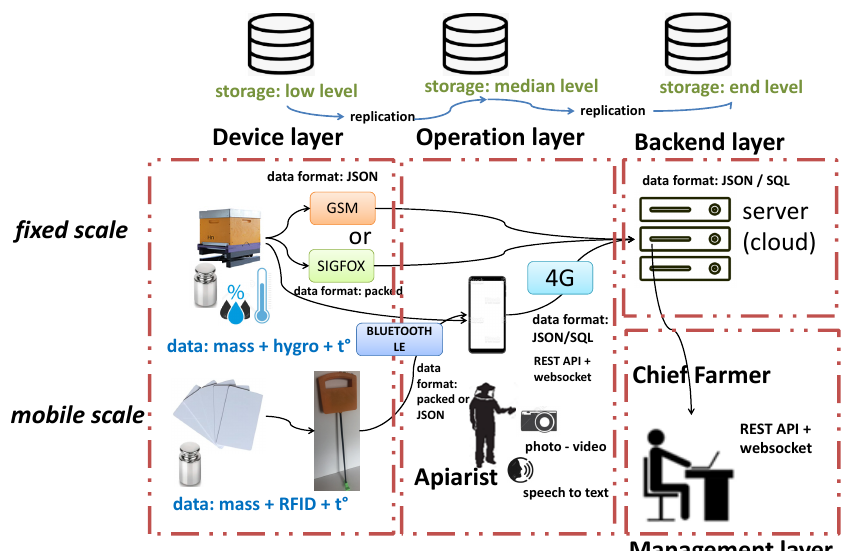
Figure 2. Implementation and Communication between different layers.